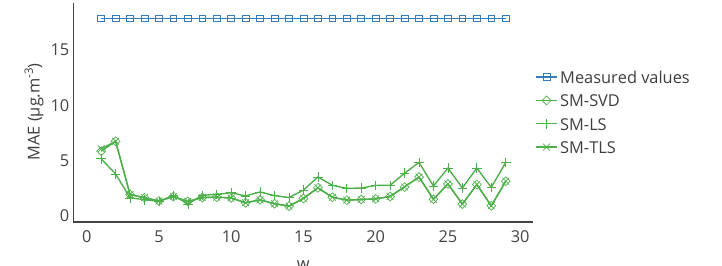
Figure 17. Evolution of the mean of MAE, computed on the entire time interval of study, over the network for the strategies SM-SVD, SM-LS and SM-TLS as a function of w . The best result is obtained for w = 7, which was our original value in Section 4, considering the average error of the three strategies for the same w .